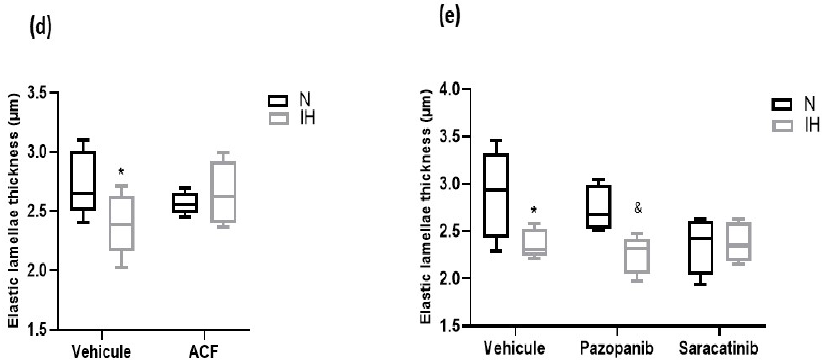
Figure 4. The effect of the inhibition of VE-cadherin cleavage pathways on aortic elastic lamellae in C57BL/6J mice. ( a ) Representative images of Weigert-stained aorta cross-sections (red arrows indicate elastic lamella disruptions). ( b ) Inhibiting HIF-1 (by ACF) prevented the elevation of elastic lamella disruptions induced by IH (Kruskal-Wallis test, * p < 0.05 vs. N + vehicle, n = 7–8). ( c ) Inhibiting src-kinases (by saracatinib) prevented the elevation of elastic lamella disruptions induced by IH. Inhibiting VEGF receptor tyrosine kinases (by pazopanib) had no effect on the elevation of elastic lamella disruptions induced by IH (Kruskal-Wallis test, *** p < 0.001 vs. N + vehicle, # p < 0.05 vs. IH + vehicle, & p < 0.05 N + Pazopanib vs. IH + Pazopanib, n = 5–8). ( d ) Inhibiting HIF-1 (by ACF) prevented the IH-induced thinning of elastic lamellae (Kruskal-Wallis test, * p ≤ 0.05 vs. N + vehicle, n = 5). ( e ) Inhibiting src-kinases (by saracatinib) prevented the IH-induced thinning of elastic lamellae. Inhibiting VEGF receptor tyrosine kinases (by pazopanib) had no effect on the IH-induced thinning of elastic lamellae (Kruskal-Wallis test, * p ≤ 0.05 vs. N + vehicle, & p < 0.05 N + Pazopanib vs. IH + Pazopanib, n = 5). N: normoxia, IH: intermittent hypoxia. Mice were exposed to N or IH for 14 days. Values are median + Interquartile range. Scale bar = 50 µm.